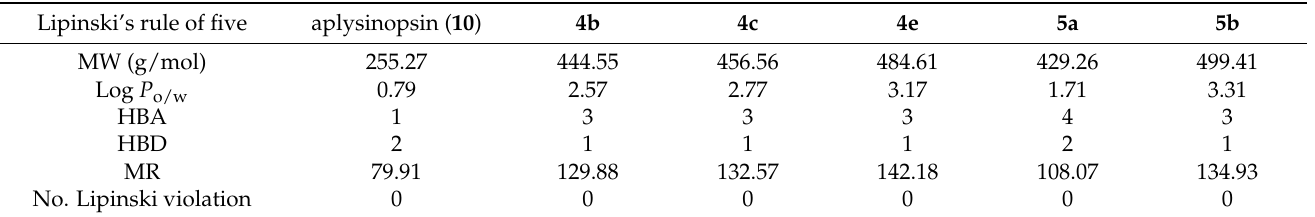
Table 1. Drug-likeness of aplysinopsin ( 10 ) and its analogs were calculated and interpreted based on Lipinski’s rule of five.